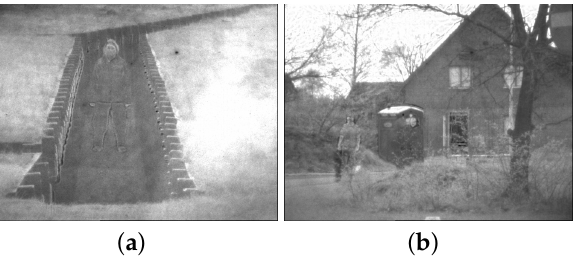
Figure 11. Results by [8] for the fusion of panchromatic VIS and IR images. ( a ) Fusion by [8] in Trench. ( b ) Fusion by [8] in